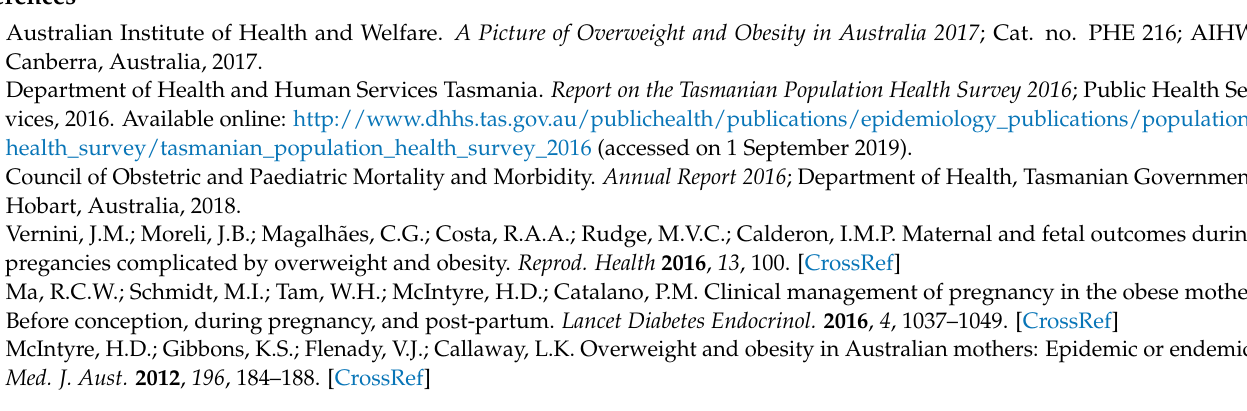
Table S23: The effect of BMI status at conception and GWG at delivery on the rate of other neonatal complications; Table S24: The effect of BMI status at conception and GWG at delivery on the rate of other birth injuries to